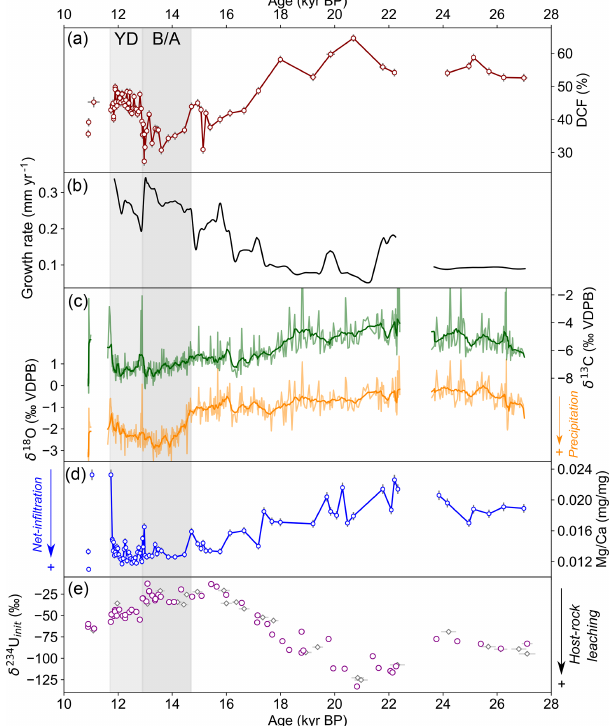
Figure 7. Combined results from stalagmite M1-5. DCF (a) , growth rate from StalAge modeling (b) , adapted stable isotope data from Shakun et al. (2007) (c) , Mg / Ca mass ratio (d) , and δ 234 U from this study (violet circles) and Shakun et al. (2007) (gray di- amonds) (e) . The gray bars indicate Bølling–Allerød interstadial (B/A) and Younger Dryas (YD) cold reversal. Oxygen data were interpreted as an increase in monsoonal rainfall over Termination I. This is corroborated by Mg / Ca precipitation proxy data, showing its lowest values in the YD, where growth rate is highest, with a decreasing trend over the end of the last glacial period. DCF shows an obvious decreasing trend after the LGM until it increases at the onset of YD. δ 18 O reaches its lowest values during the B/A warm period, indicating an intensified monsoonal precipitation (Shakun et al.,